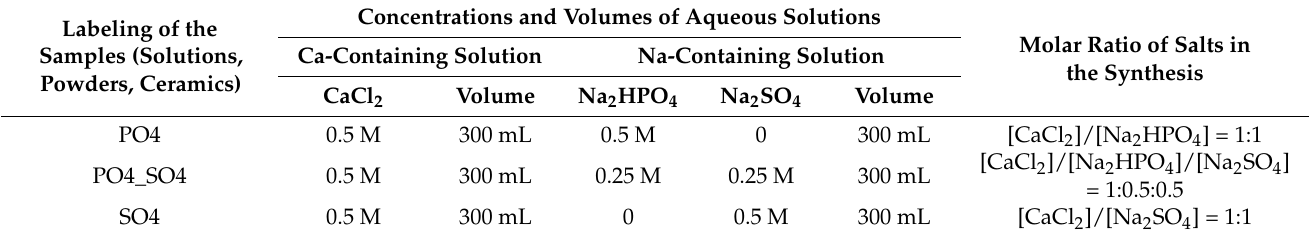
Table 1. Synthesis conditions and labeling of the